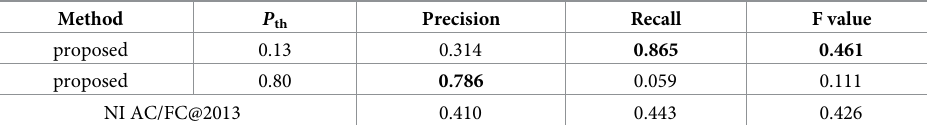
Table 13. Results of future NI AC/FC